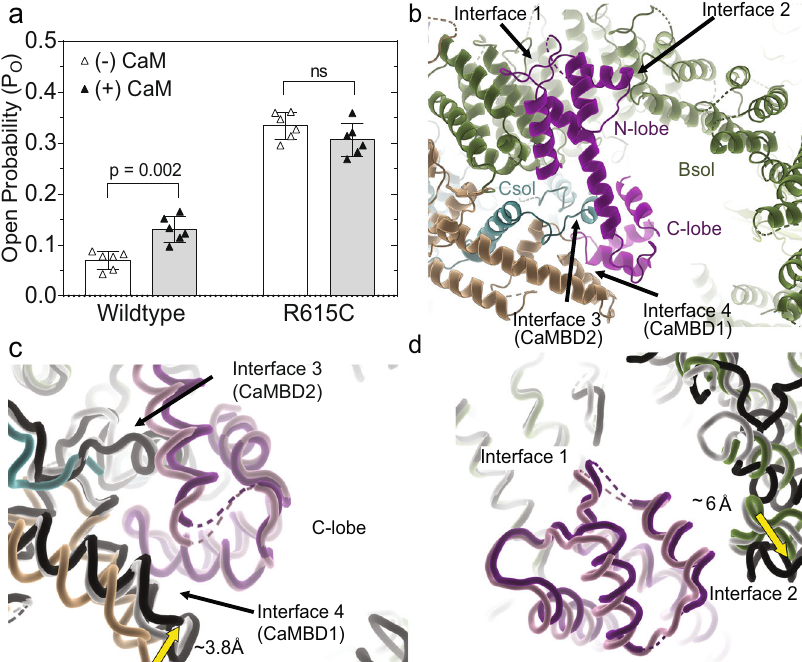
Fig. 4 Effect of apoCaM on RyR1. a Single-channel open probability (P o ) of wild type and R615C RyR1 with ( fi lled) and without (open) 1 μ M calmodulin (mean ± SD, Mann – Whitney two-tailed t -test, n = 6 with each independent recording corresponding to a newly incorporated channel from a different liposome) at low calcium ([Ca 2 + ] free = 40 nM) and with 2 mM ATP. Single-channel recordings were carried out under symmetrical conditions ([ cis ] = [ trans ]) with a constant − 60 mV holding potential. b Binding of apoCaM (purple) at the periphery of the cytosolic cap, showing contacts of the N-lobe with two regions of the Bsol (interface 1 and interface 2). The C-lobe interacts with CaMBD1 and CaMBD2 segments. c Superposition, based on interface 1 helices, of WT pRyR1 without CaM (colors) on closed pRyR1 + apoCaM (white) and open pRyR1 + apoCaM (black). The corresponding apoCaM chains are shown in light (closed pRyR1) and dark purple (open pRyR1). The panel shows a detail around the C-lobe, showing the relative movement of the Jsol toward the C-lobe compared to the structure without apoCaM bound. CaMBD2 is only visible in the apoCaM bound structure. The interactions in this area are very similar for open and closed pRyR1 structures with apoCaM bound. d Same superposition as in panel ( c ), but showing the interfaces with the N-lobe. The interface 2 interaction is different for the open pRyR1 in complex with